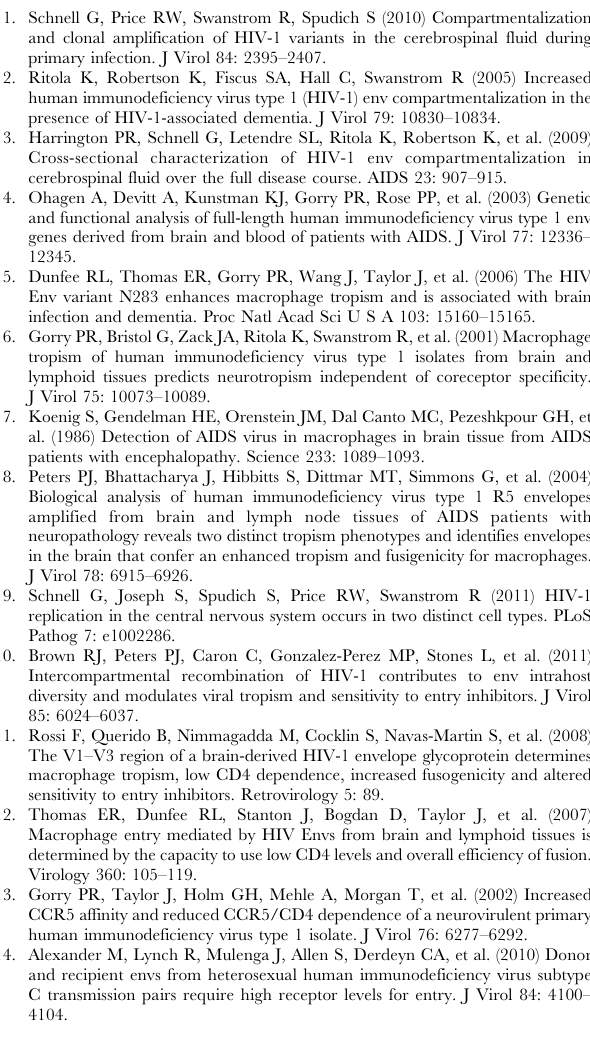
CSF, accounting for the equilibrated state observed for this patient. (TIF) Figure S6 No contamination was observed between subjects. Neighbor-joining phylogenetic tree (radial topology). env sequences from the CSF are labeled with solid blue circles and env sequences from the blood plasma are labeled with solid red triangles. Genetic distance is indicated at the bottom of the figure and indicates the number of nucleotide substitutions per site between env sequences. Each subject ID is indicated.